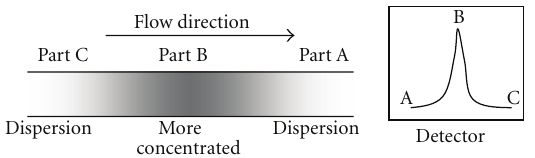
Figure 2: Product zone in the flow